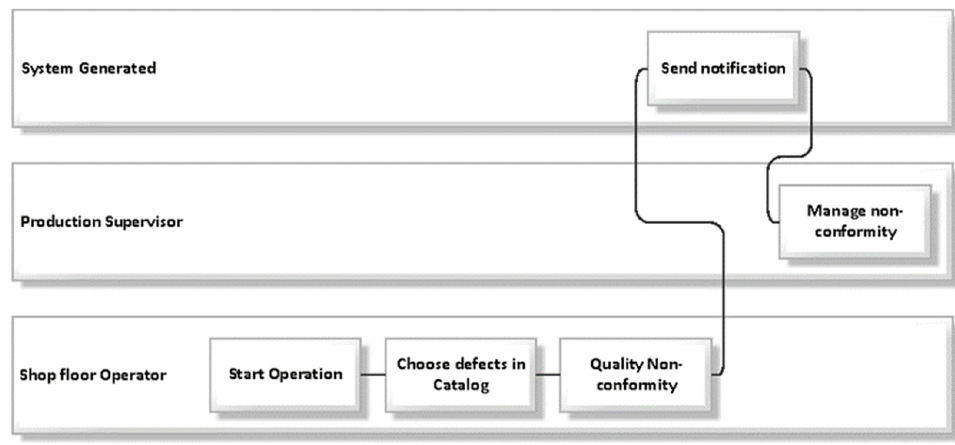
Figure 3. Defect declaration scheme [27].